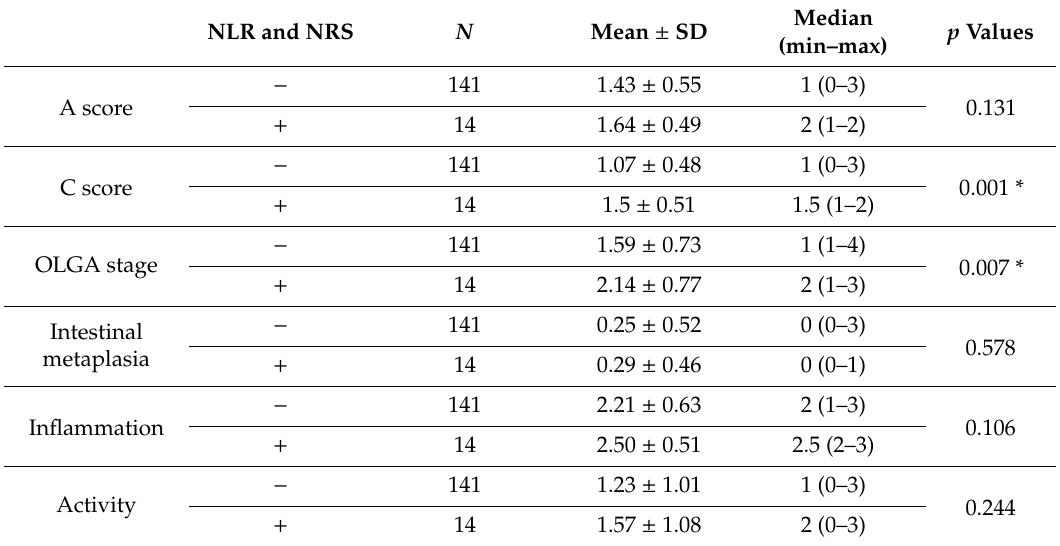
Table 4. Comparison of gastric parameters according to NLR and NRS groups ( n = 155).